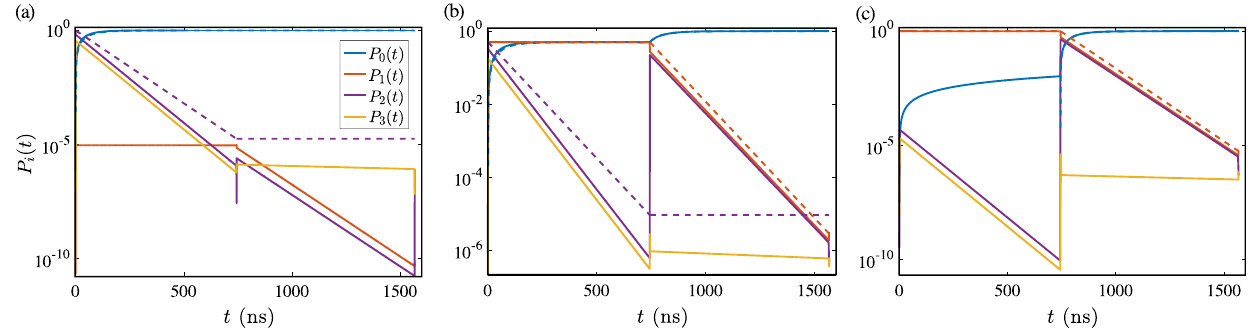
Fig. 5 Dynamics of the occupation probabilities of the low-energy eigenstates. We show results for the initial probabilities P 0 (0) = P 3 (0) = 0, and a P 1 (0) = 0 and P 2 (0) = 1; b P 1 (0) = P 2 (0) = 0.5; c P 1 (0) = 1 and P 2 (0) = 0. Analytic occupation probabilities are shown with dashed lines , and obtained from Eq. (22) by assuming sudden sweeps. The used parameters are shown in Table 1. In the numerical solutions, the sweep time t s = 1 ns and α ( τ ) = 10 −